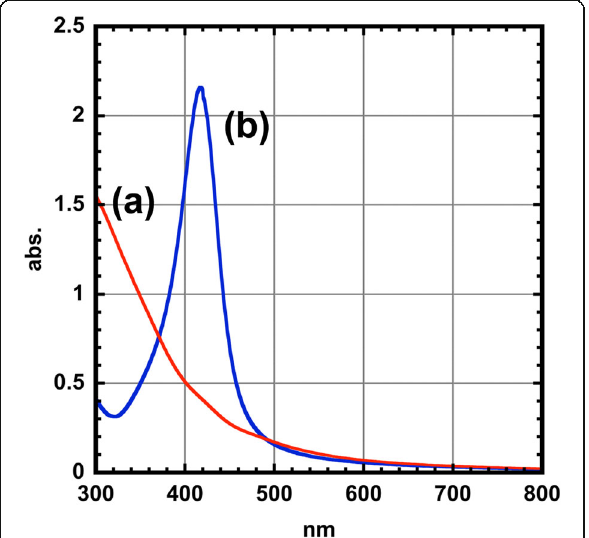
Fig. 5 UV-vis spectra for ( a ) CoFe 2 O 4 nanoparticles (red line) and ( b ) CoFe 2 O 4 @Ag nanoparticles (blue